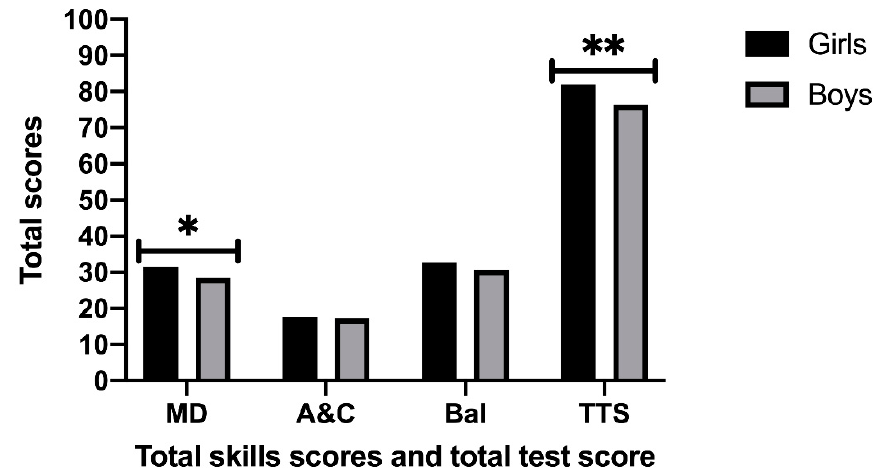
Figure 1. Total Skill Scores and Total Test Score regarding gender. Note : MD: Manual dexterity; A&C: Aiming and Catching; Bal: Balance; TTS: Total Test Score. * Significant differences p < 0.001; ** Significant differences p < 0.05.